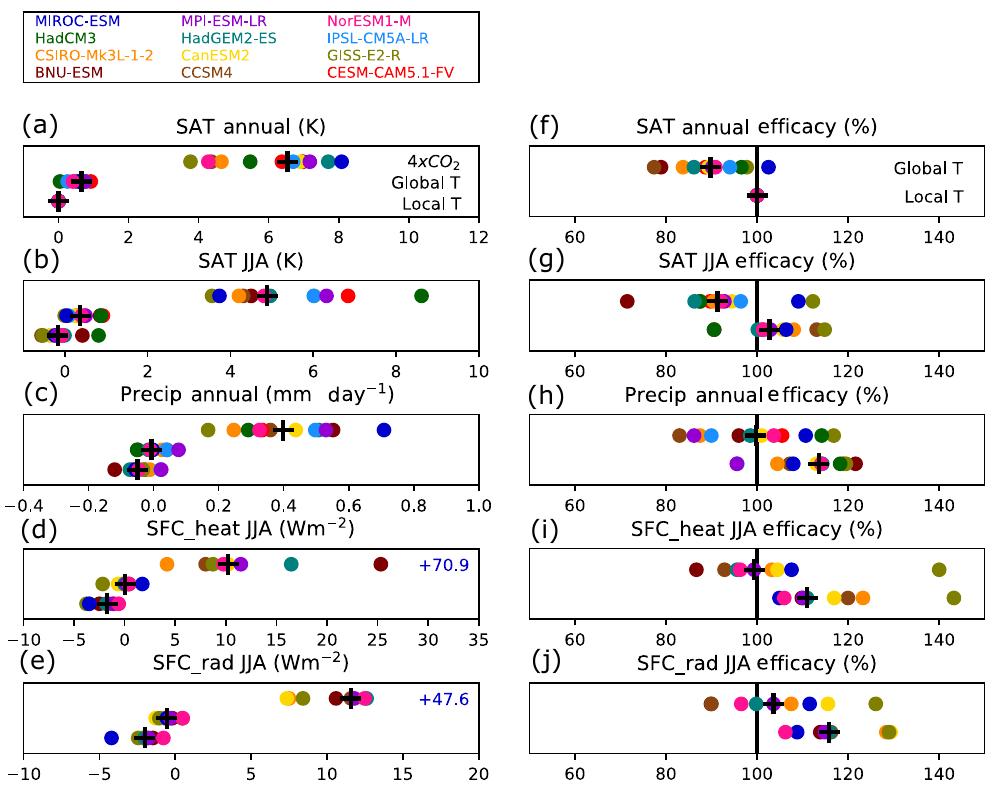
Figure 1. Regional-mean anomalies (a–e) and efficacies (f–j) of G1 ∗ and G1-Greenland at offsetting 4 × CO 2 − control regional-mean anomalies for Greenland for each model within the GeoMIP G1 ensemble. In (a–e) , the upper points show the 4 × CO 2 − control anomaly, the middle row of points show the G1 ∗ results, which restore global mean temperature, and the lower points show the results for G1- Greenland, which restores local temperature. The ensemble median is shown with a plus symbol. The results from some outlier points have been displayed as text in the color of the corresponding model. SFC_heat is the net heat flux into the surface, i.e., net SW + net LW − sensible heat − latent heat, and SFC_rad is the net radiative flux into the surface, i.e., net SW + net LW. Efficacy is defined in the text. Where data were unavailable these models have not been plotted for those